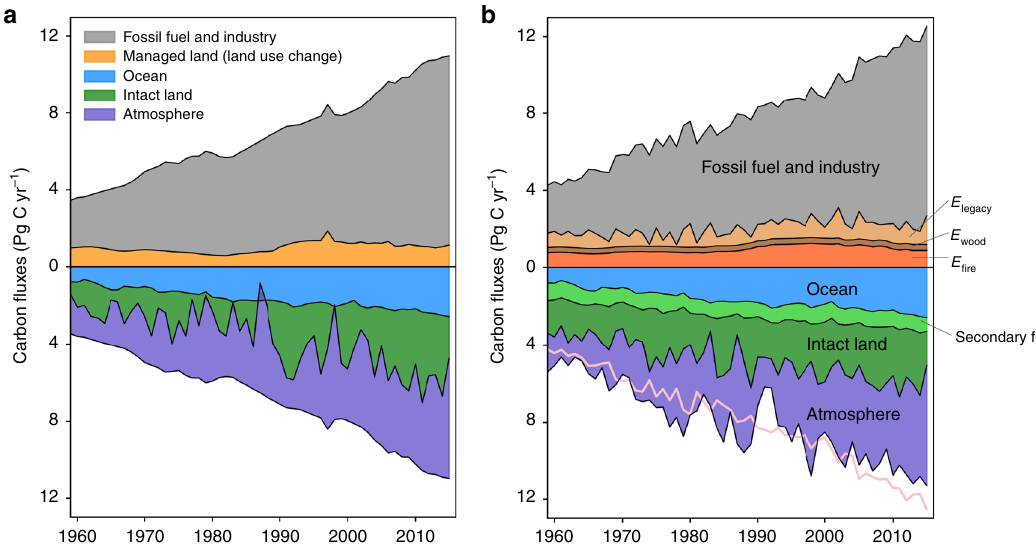
Fig. 5 Overview of the global carbon cycle for 1959 – 2015. a E LUC was derived from the HN2017 bookkeeping model with the intact land sink, as a residual of the global carbon budget. b All E LUC component fl uxes and the intact land sink were simulated by ORCHIDEE. Note that all land fl uxes by ORCHIDEE include full impacts of environmental changes and climate variations. The difference between the bottom edge of the atmosphere sink and the pink line in b indicates the mismatch between the modeled and observation-based global carbon budgets.